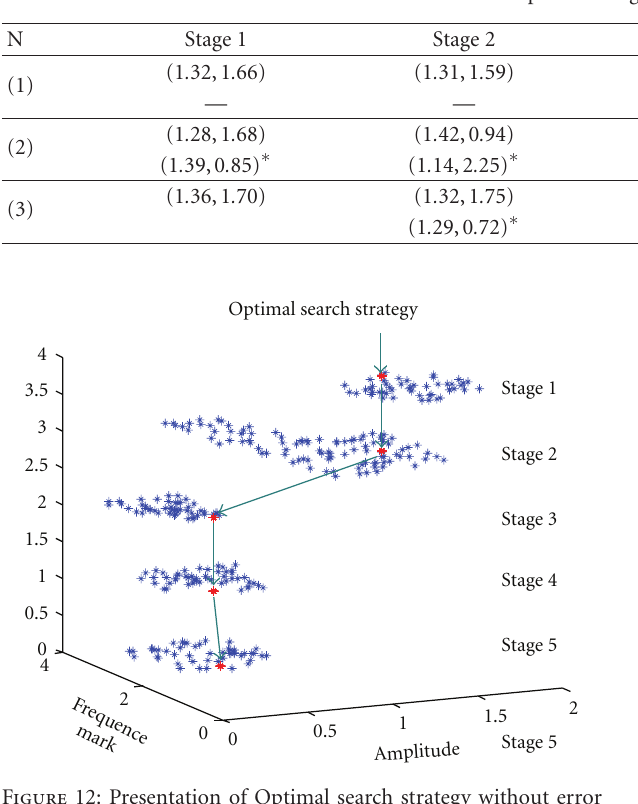
Table 1: Examples of using optimal search strategy.